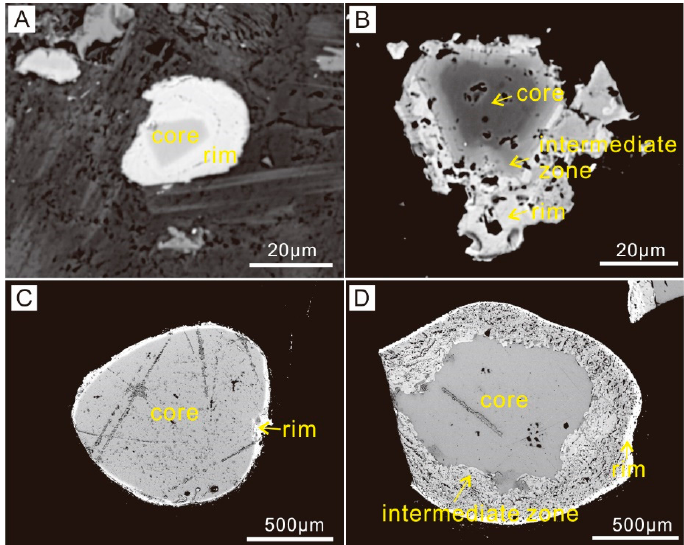
Figure 1. Backscatter electron (BSE) images of magmatic spinels ( A,B ) and xenocrystic spinels ( C,D ) from the No.30 kimberlite. Magmatic spinels show compositional zones from the Ti-Al-Mg chromite core through the Ti-Al chromite intermediate to the magnetite rim, and spinel xenocrysts show compositional zones from xenocrystic magnesiochromite core through the Ti-Al-Mg chromite intermediate to the magnetite rim.